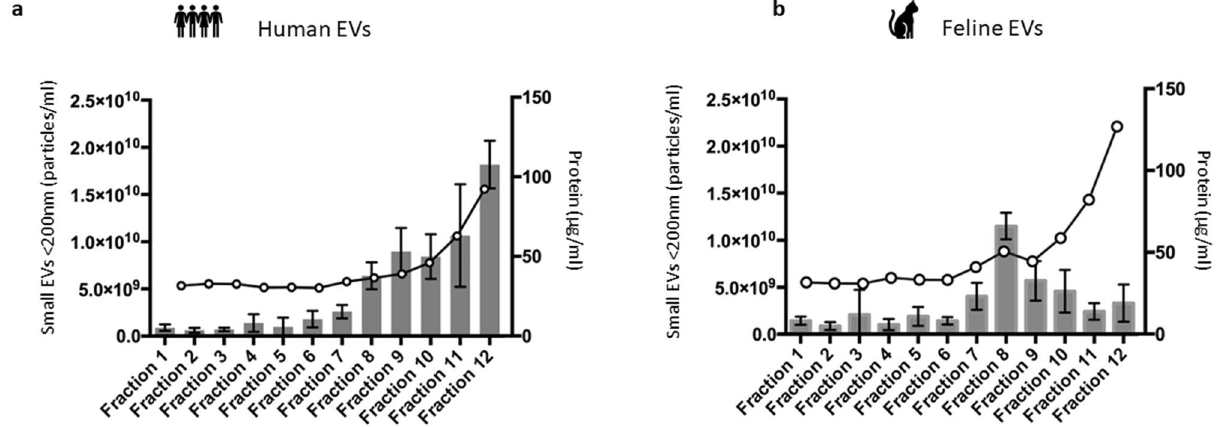
Figure 2. Nanoparticle tracking analysis (NTA) of the number of small EVs (< 200 nm) in each fraction isolated from the plasma of ( a ) humans and ( b ) felines by SEC. Protein concentration (-0-) of each fraction isolated by SEC from the plasma of ( a ) humans and ( b ) felines by BCA. (a) The enrichment of small EVs in human plasma within fractions 7–10 is shown. The protein concentration also increases in later fractions, with fractions 11 and 12 containing substantially more protein than previous fractions. (b) The enrichment of small EVs in feline plasma within fractions 7–10 is shown. The protein concentration increases in later fractions, with fractions 11 and 12 containing substantially more protein than previous fractions. This figure confirms that the majority of small EVs are contained in fractions 7–10, while fractions 11 and 12 from both human and feline plasma contain substantially more co-isolated contaminating protein than previous fractions. A high protein to particle ratio has been shown to indicate contamination by plasma proteins 5